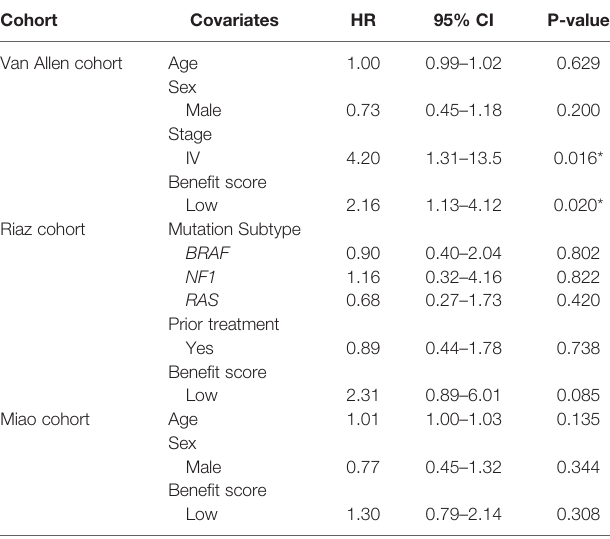
TABLE 1 | Multivariate Cox regression analysis of overall survival with the bene fi t score and other covariates in different cohorts. Cohort